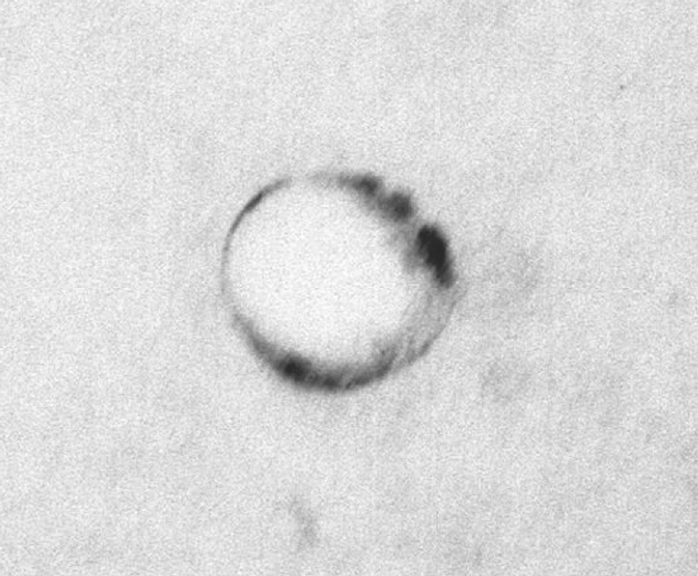
Figure 2. Transmission electron microscope (TEM) image of Ketorolac tromethamine (KT)-loaded elastic liposome (X